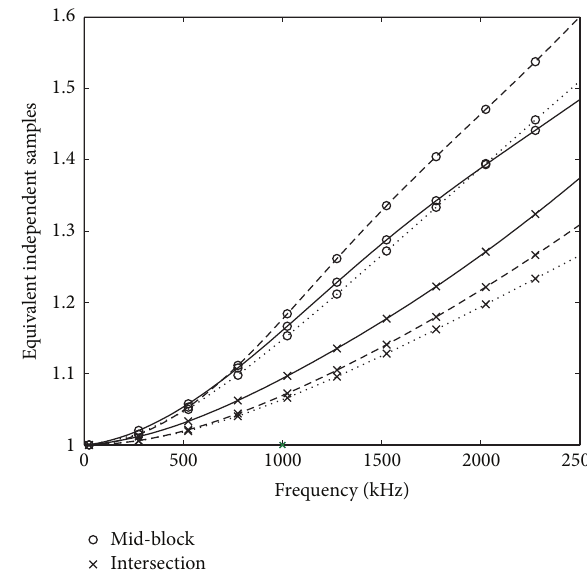
Figure 6: Average equivalent independent samples for frequency- correlated data at 370 MHz (solid lines) and 2GHz (dashed lines) and for exponential delay model (7) (dotted